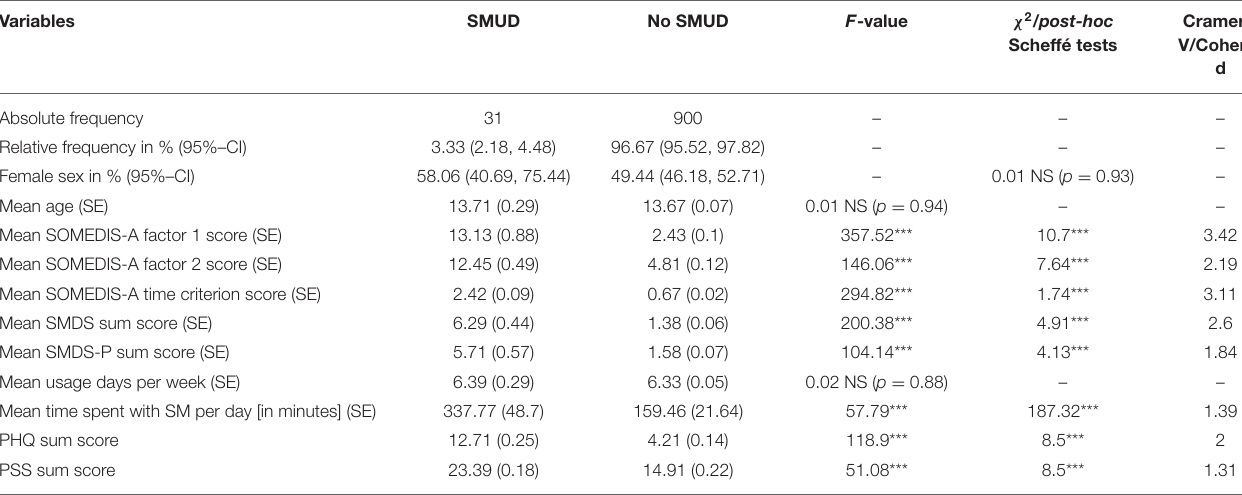
TABLE 6 | MANOVA and post-hoc test results on adolescents ROC-classified with/without SMUD. Variables